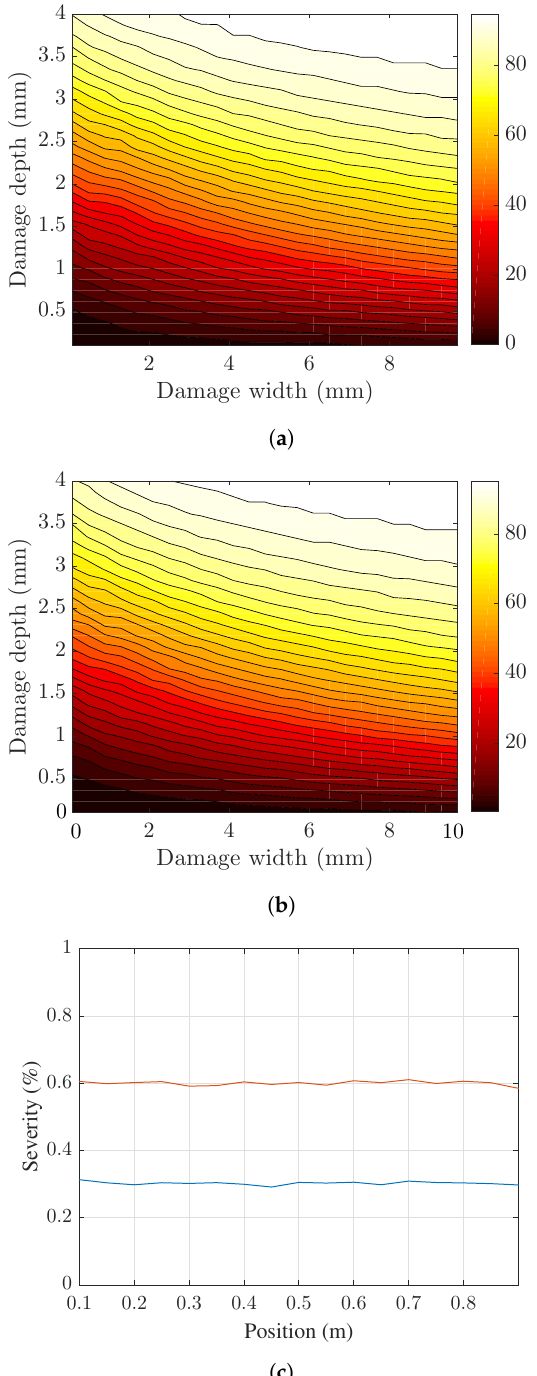
Figure 6. Contour view of the damage libraries which is built at position ( a ) 0.30 m and ( b ) 0.50 m. ( c ) Severity equivalent to a damage 1 mm × 1.5 mm (blue) and 1 mm × 2.5 mm (red) for varying position along the